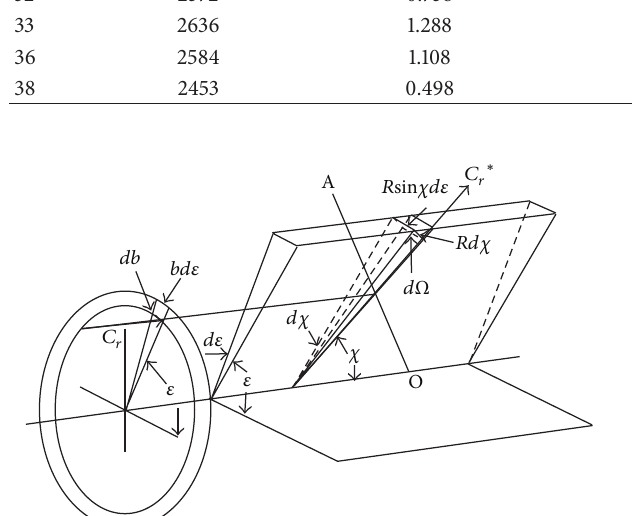
Figure 2: Illustration of the impact parameters [4].